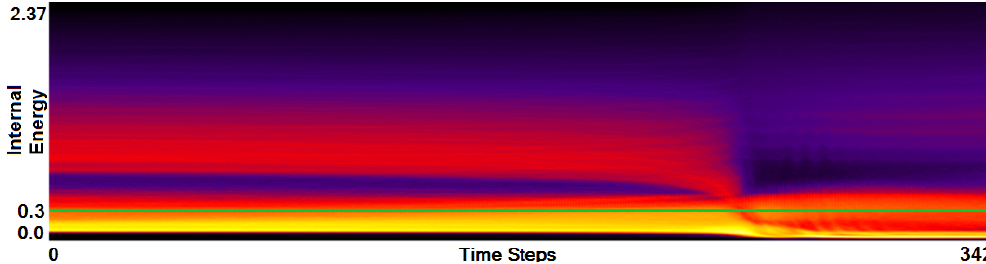
Figure 11. Function plot representing standard deviation from Figure 10. Despite of similar structure of the field distribution in all simulation runs in the ensemble, this plot shows high deviations for lower field values. Green horizontal line indicates selection of representative field value used for isocontour similarity computation.